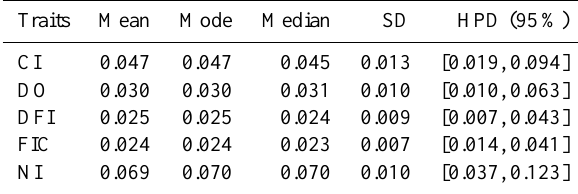
Table 2. Summary of marginal distributions of the heritability of CI, DO, DFI, FIC, and NI. HPD: high posterior density region. Traits